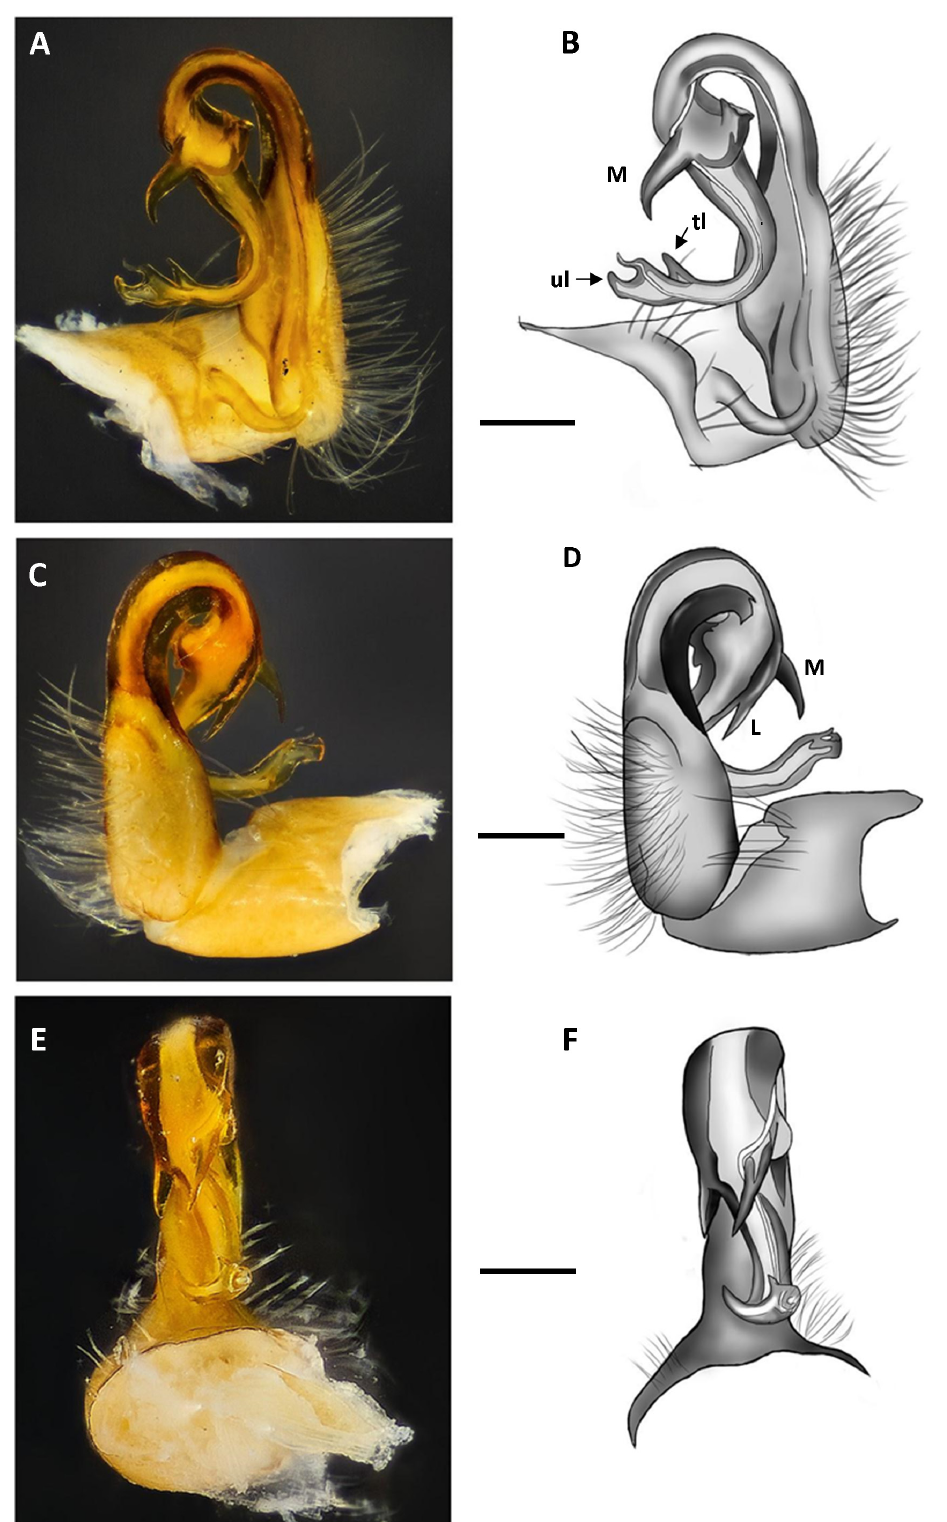
Fig. 7. Pogoro scharffi Hoffman, 2005, paratype, ♂ , left gonopod (NHMD 621669). A–B . Mesal view. C–D . Lateral view. E–F . Dorsal view. Abbreviations: L = Process L; M = Process M; tl = triangular lobe; ul = uncate lobe. Scale bars: 0.5